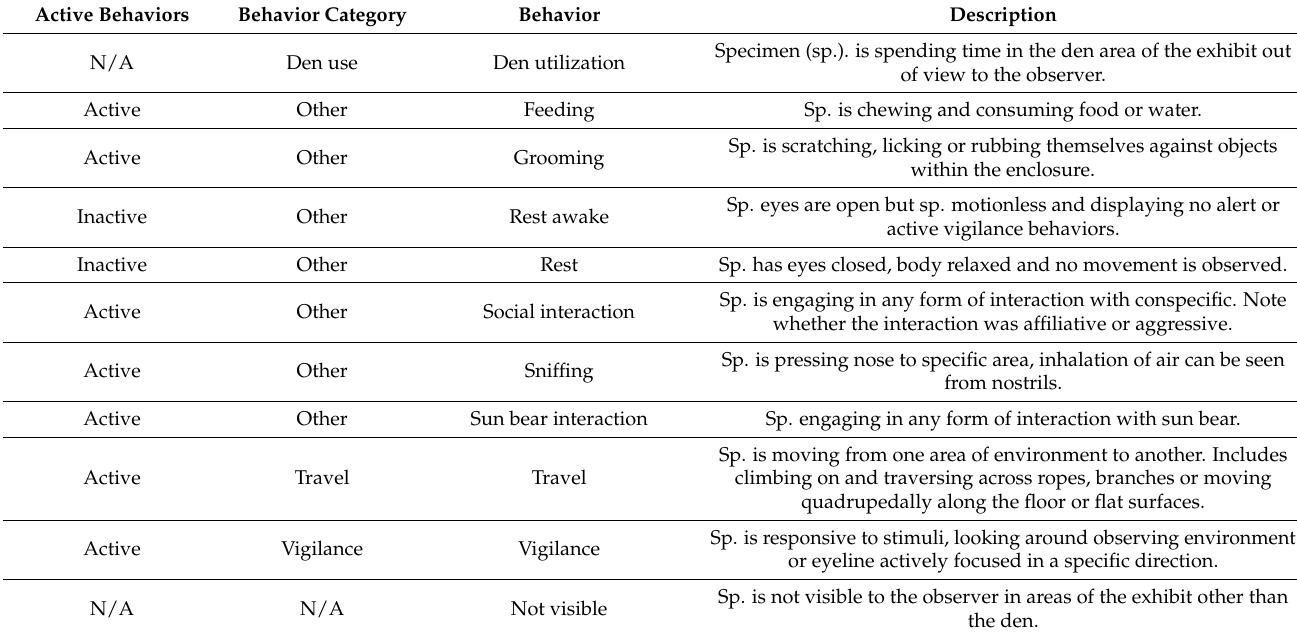
Table 1. Species-specific ethogram for binturong ( Arctictis binturong whitei ), with descriptions of each behavior outlined. Active behavior category highlights behaviors included when evaluating activity levels. Behavior category highlights how individual behaviors were grouped for behavior